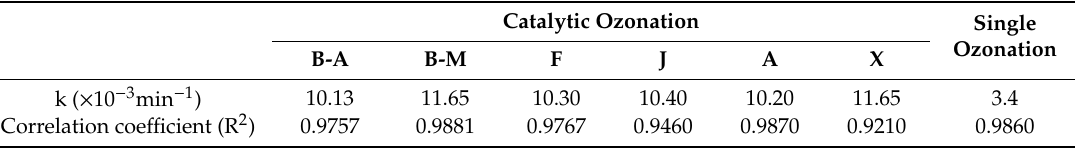
Table 3. Kinetic constants of COD removal by the catalytic ozonation or single ozonation